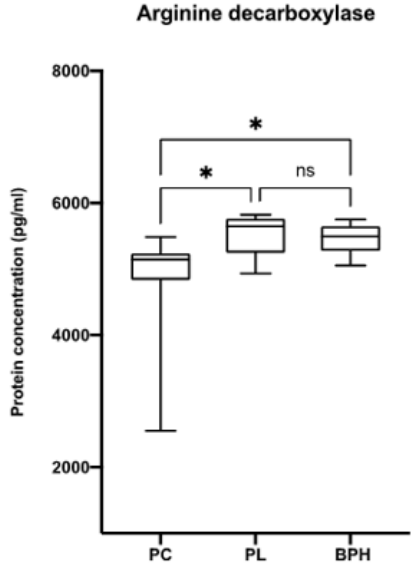
Figure 6. ( A ) ROC curve diagram of agmatine sensitivity and specificity in prediction of pathologi- cal conditions in PC and BPH patients. ( B ) Boxplots showing the distribution of agmatine among subjects with prostate cancer (PC, n = 92), precancerous lesions (PL, n = 26), or benign prostatic hy- perplasia (BPH, n = 49). The centre line of the boxplots indicates the median (limits of the box indi- cate the 25th and 75th percentile). The whiskers represent either 1.5 times the interquartile range (IQR) or the maximum/minimum data point if they are within 1.5 times the IQR. Wilcoxon’s test was used to compare mean agmatine levels among groups.